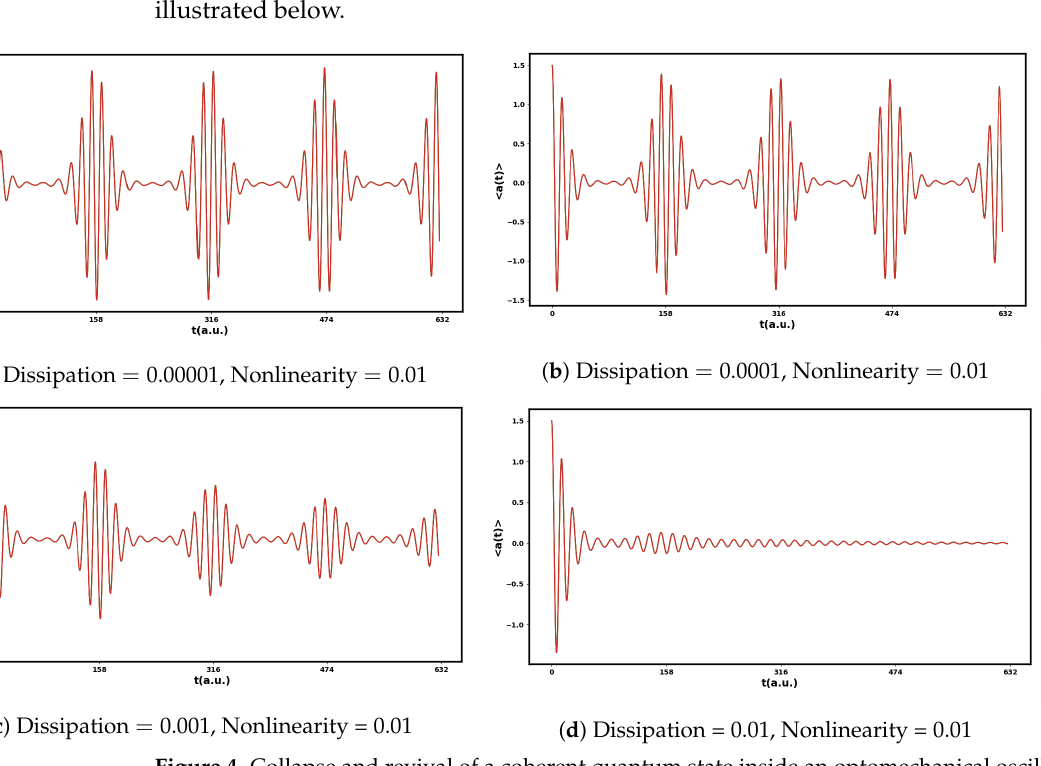
Figure 4. Collapse and revival of a coherent quantum state inside an optomechanical oscillator with nonlinearities k c = k m = 0.01 a.u. for four different values of dissipation. ( a ) γ c = γ m = 0.00001 a.u., ( b ) γ c = γ m = 0.0001 a.u., ( c ) γ c = γ m = 0.001 a.u. and ( d ) γ c = γ m = 0.01